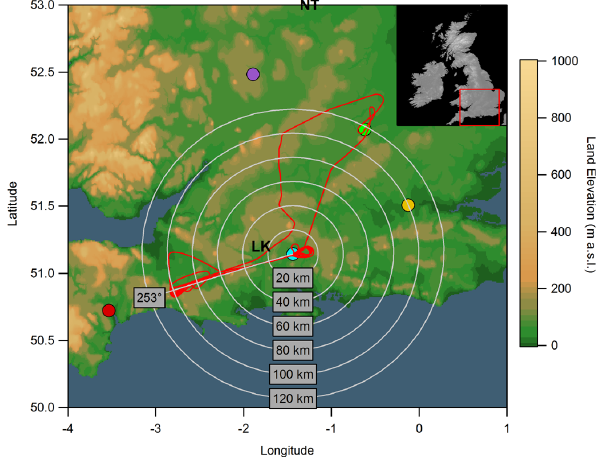
Fig. 1. Flight track of the FAAM BAe146 aircraft (in red) on 18 February 2009. Locations identified by markers include London (yellow), Exeter (red), Cranfield (green), Birmingham (purple) and the CFARR ground site (blue). Range rings at 20km spacing and along the 253 ◦ radial from CFARR are in grey.